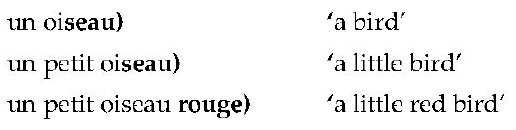
Figure 3. French phrase-final prominence.